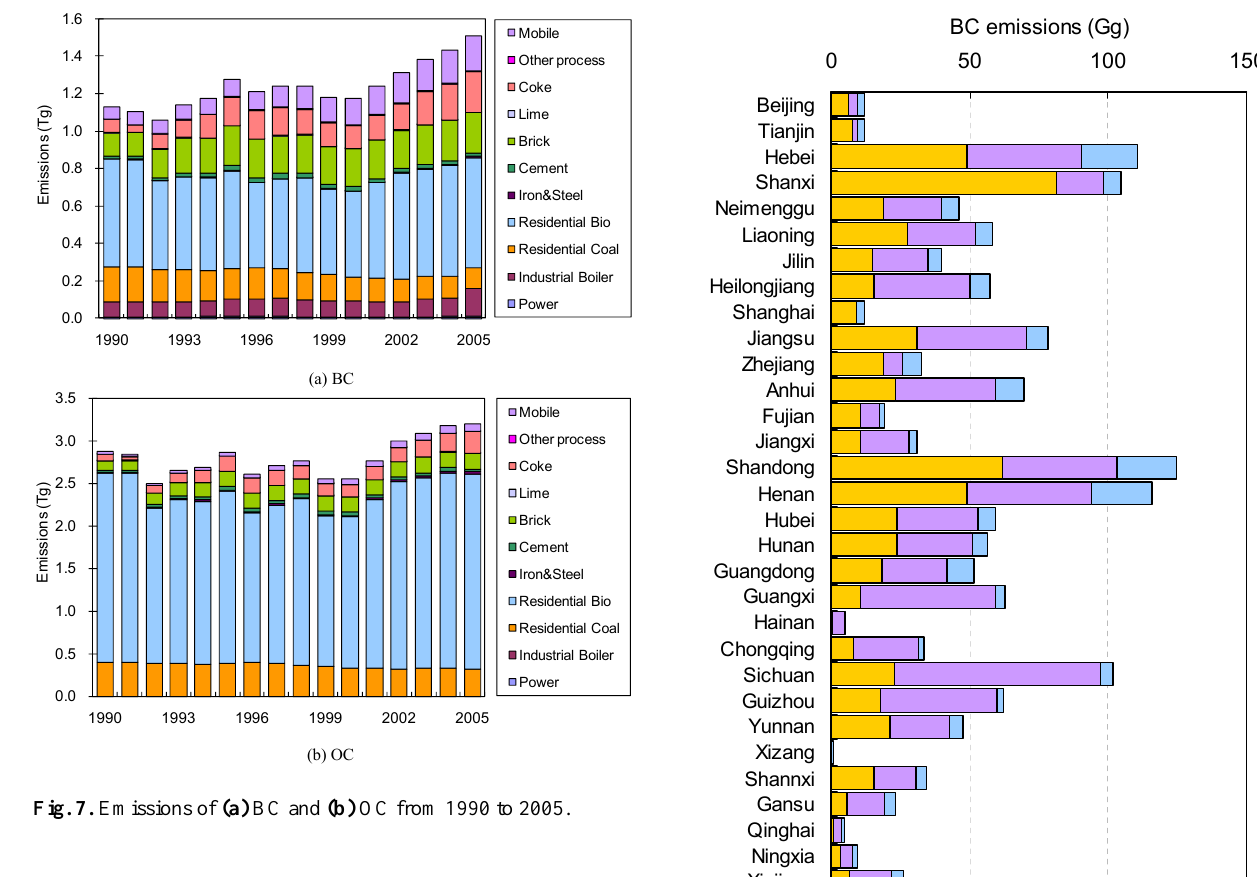
ysis identified. Industries such as coke and brick-making plants are the most significant contributors in northern China (Hebei, Shanxi, Shandong and Henan), while the residential sector is the dominant source of emissions in the south, and especially in the southwest (e.g. Guangxi, Chongqing